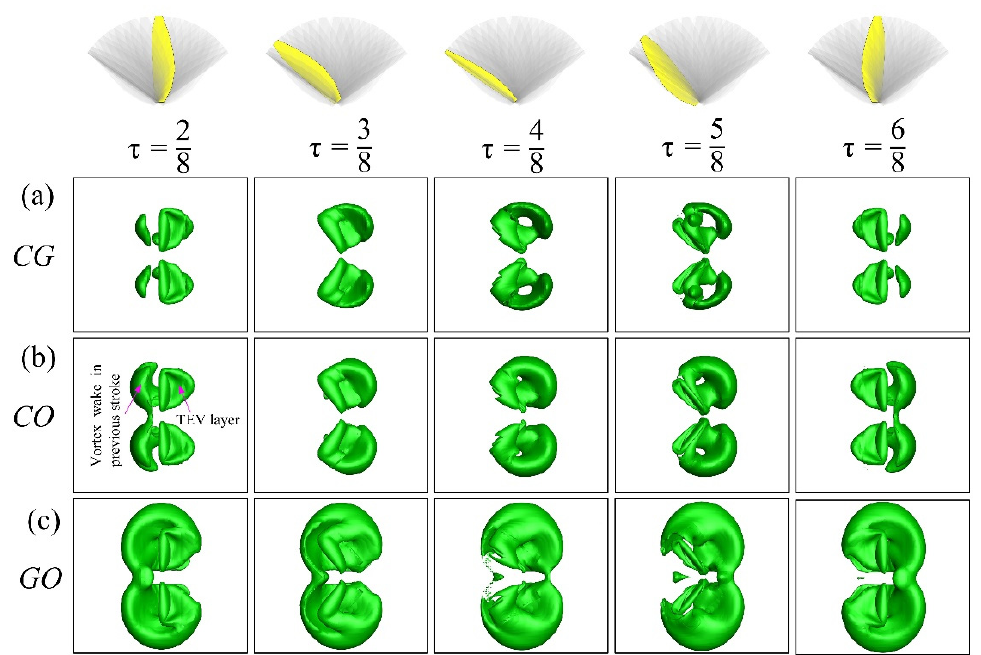
Figure 15. Top view of the iso-Q surface (green) with vortex wake for ( a ) the combined ceiling and ground case (referred to as CG ); ( b ) the ceiling-only case (referred to as CO ); and ( c ) the ground-only case (referred to as GO ) at D / c = 4.0 for different times at Re = 10. The non-transparent wing in the first row indicates the position of the wing at the corresponding time.